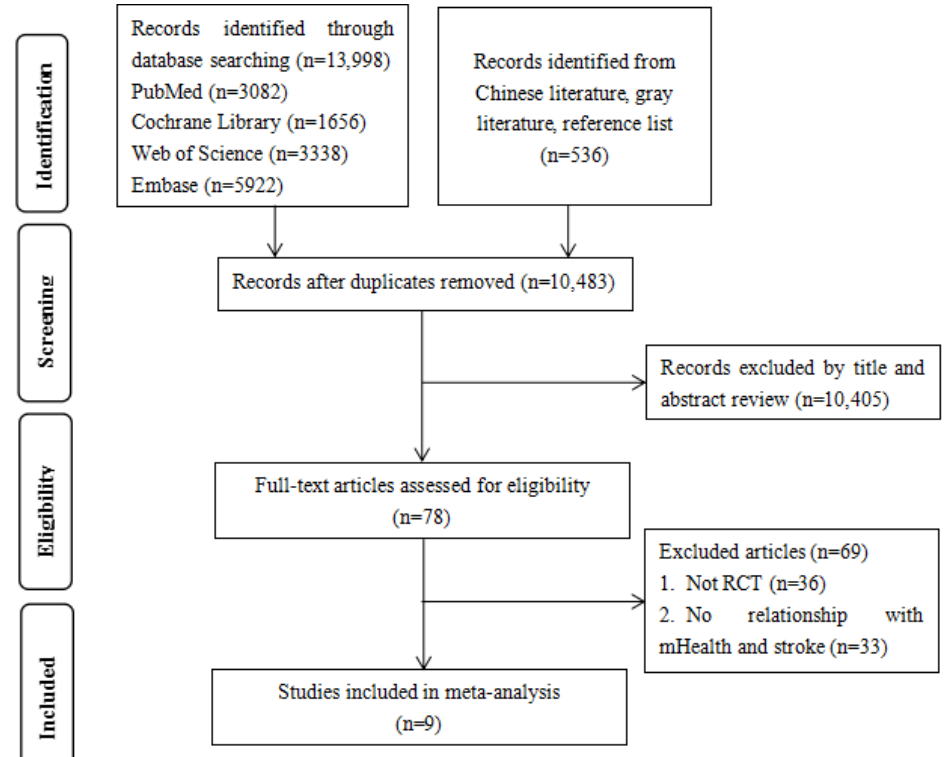
Figure 1. Flow diagram of the selection of studies. mHealth: mobile health; RCT: randomized controlled